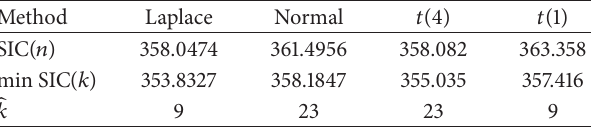
Table 4: Minimum SIC values in Holbert data based on different